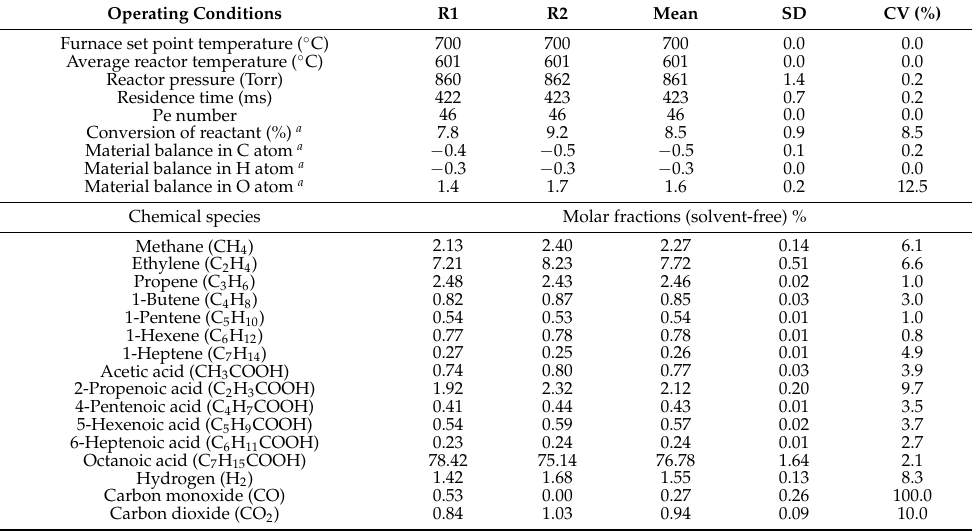
Table 5. Standard deviations (SD) and coefficients of variation (CV) on experimental results generated in this work to validate the designed bench-scale setup—Case study of octanoic acid pyrolysis- Experiments R1 and